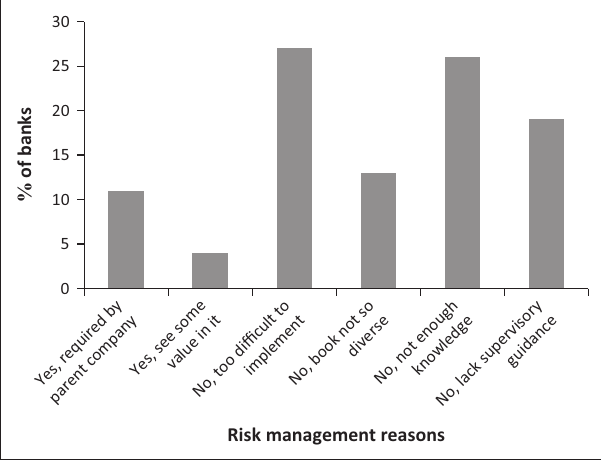
FIGURE 10: Reasons for regarding the internal capital adequacy assessment process as a useful risk management tool.